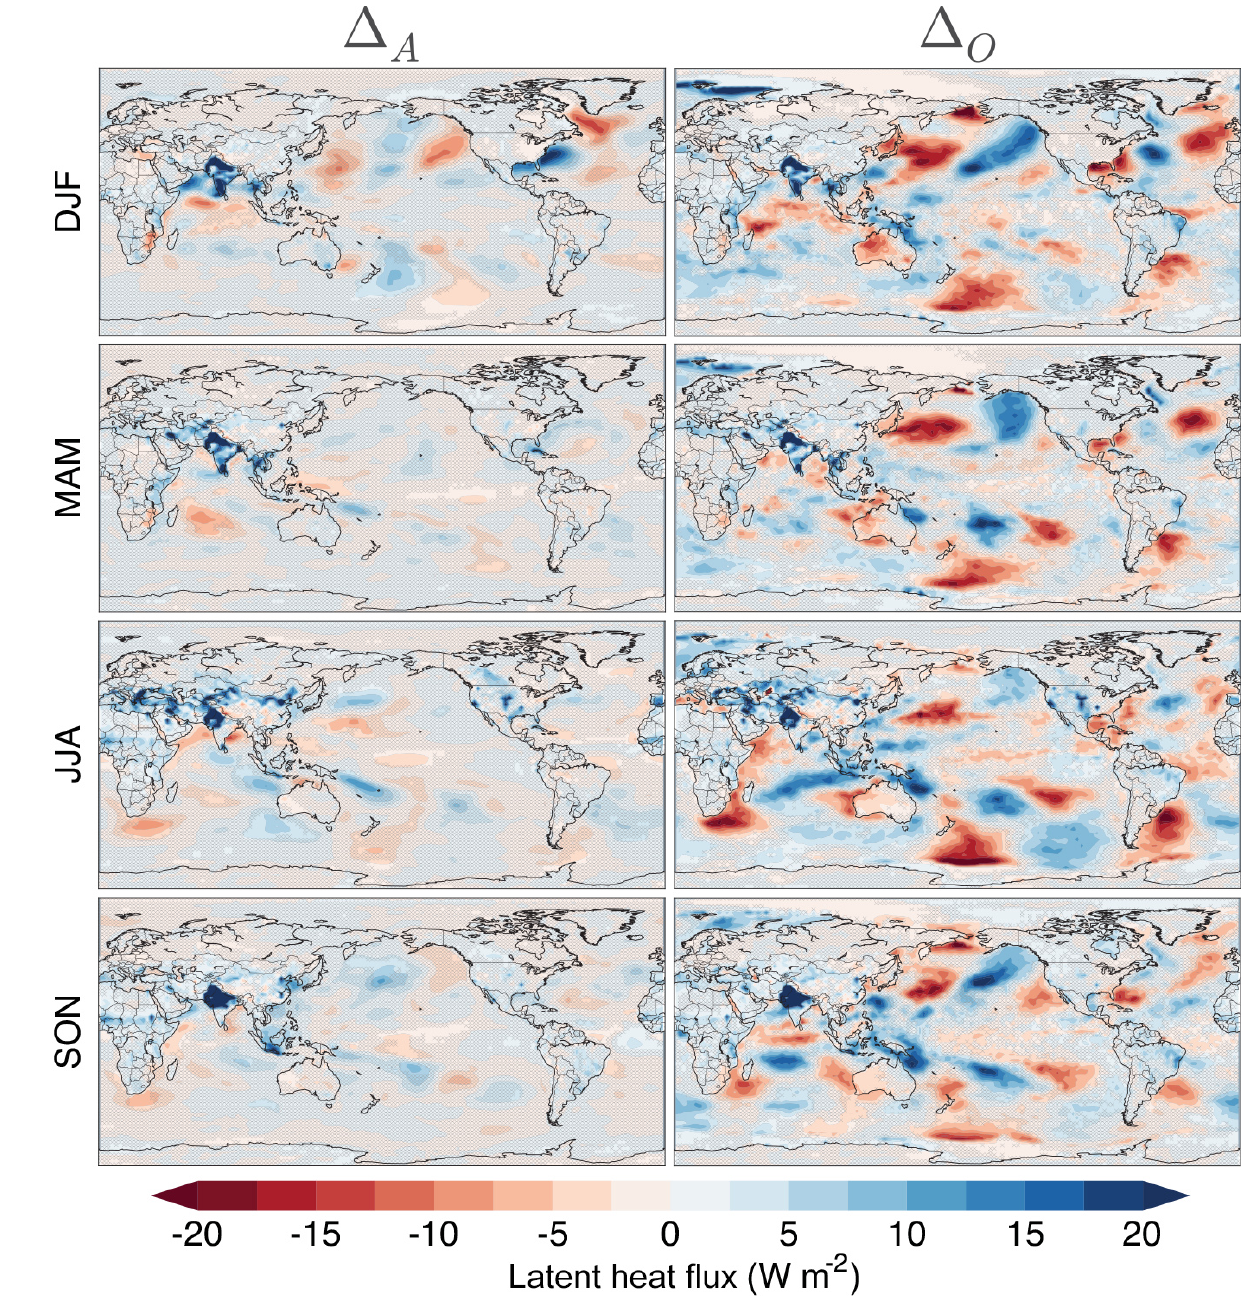
Figure 8. Same as Fig. 3 but for surface latent heat flux differences (Wm − 2